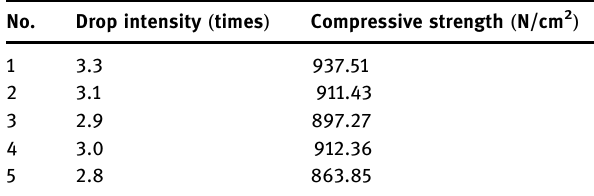
Table 13: Strength of the converter slagging agents